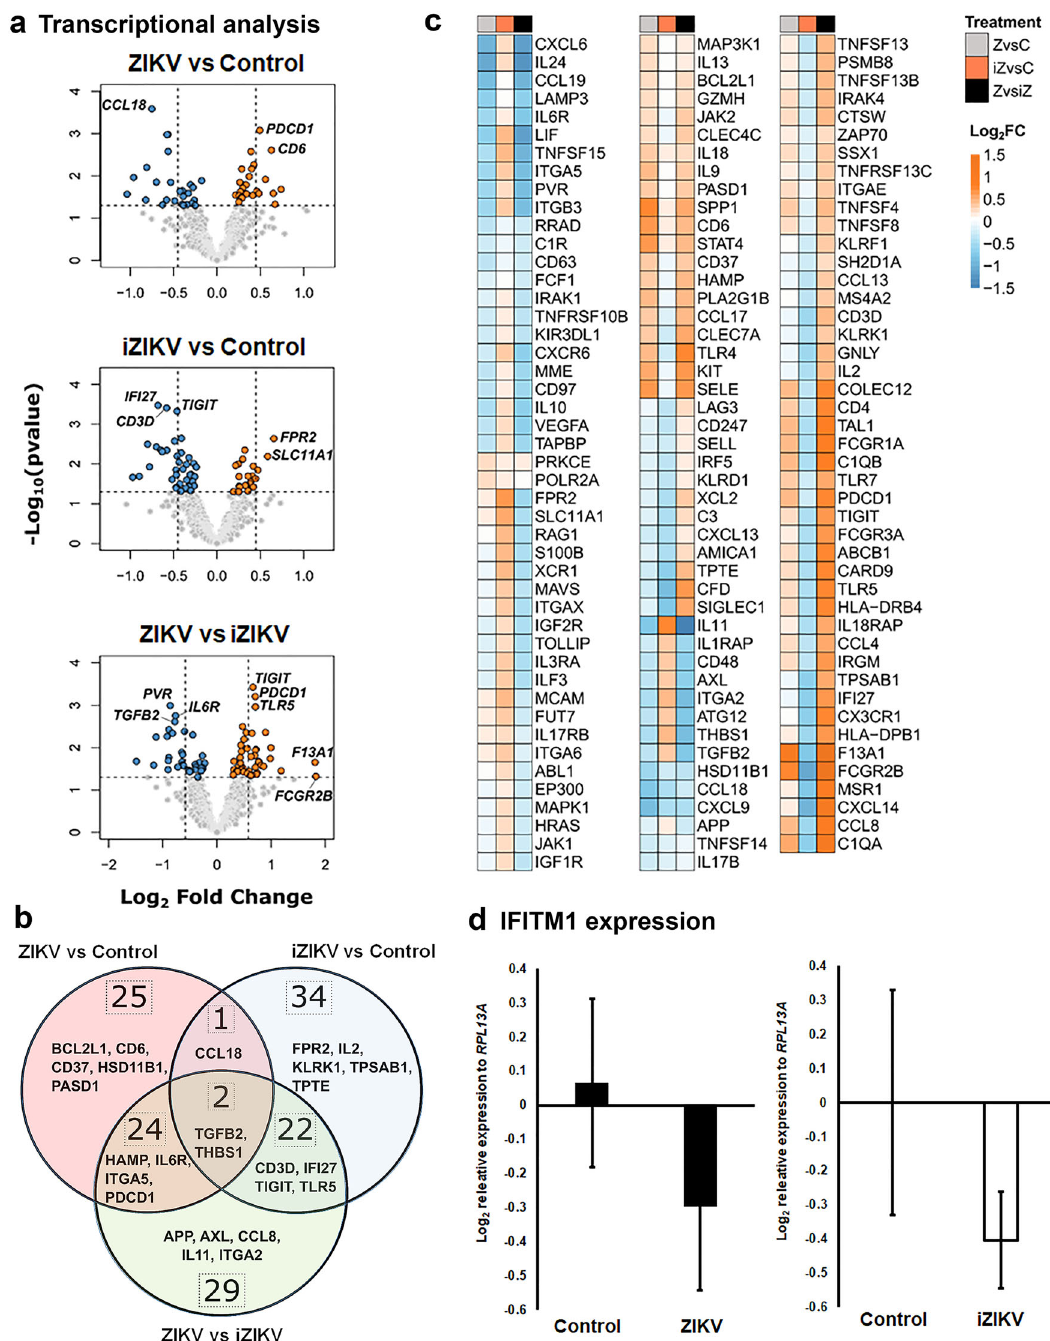
Fig. 9 Transcriptional changes with ZIKV and iZIKV perfusion. a – c nCounter transcriptional analysis in virus perfused vs. Control cotyledons ( n = 5 samples per condition). a Volcano plots of differentially expressed (DE) genes among respective comparisons. Points on the plots represent individual genes. Hashed lines denote a p value < 0.05, absolute log 2 fold change > 0.45 for ZIKV and iZIKV vs. Controls, and absolute log 2 fold change > 0.58 for ZIKV vs . iZIKV wherein the top genes are annotated. Differentially expressed (DE) genes signi fi cantly upregulated are shown in red while those downregulated are blue. ( b ) Venn diagram annotating the total number and overlap for signi fi cant DE genes between comparisons. The top fi ve most signi fi cant genes based on the limma moderated t -statistic are annotated. c Heatmaps denoting all signi fi cant ( p < 0.05) DE genes, clustered by complete linkage on Euclidean distances of log2 fold change values. d The relative expression of IFITM1 by qRT-PCR in most of the same samples ( n = 5 – 7 per condition) examined by the nCounter. Control samples re fl ect cotyledons from the same placentas used for either ZIKV or iZIKV perfusions respectively. Box-plots represent the median in the centerline, upper and lower quartiles at top and bottom of box, min/max points as whiskers, and the mean with x. of Hanks ’ Balanced Salt solution pH 7.4 (Sigma-Aldrich, St. Louis, MO, USA), vein were cannulated for perfusion. Two butter fl y needles were inserted just containing 2 g/L Albumin (Sigma), 2000 U/L Heparin (Patterson Veterinary below the chorionic plate to simulate maternal perfusion (Fig. 1a). Cotyledons Supply, Devens, MA, USA) 5 mg/L Gentamycin, and 0.35g/L Sodium Bicarbonate were placed in customized enclosures within an incubator at 36°C. Cotyledons (Sigma). The remaining placental tissue was utilized to provide the baseline were continuously perfused with warmed and oxygenated media that was not references. These samples designated as “ baseline ” , constitute fresh unperfused recirculated, within a laminar hood following BSL2 standards. The media consisted COMMUNICATIONS BIOLOGY| (2022) 5:243